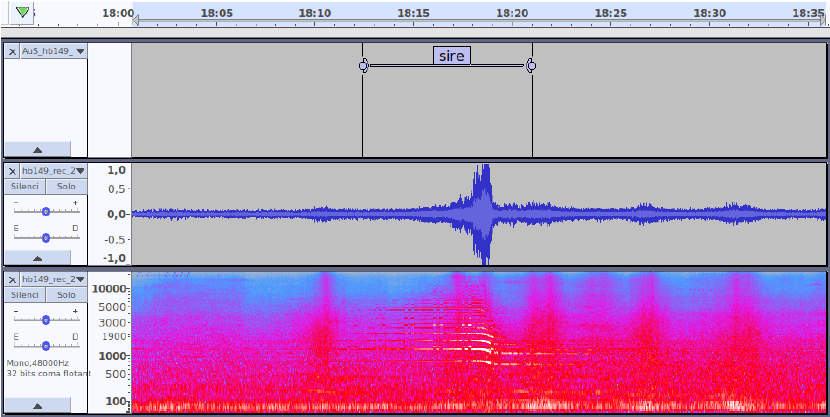
Figure 4. Example of the labeling of a siren using Audacity, with the label on top, the signal in the middle and the spectrum on the